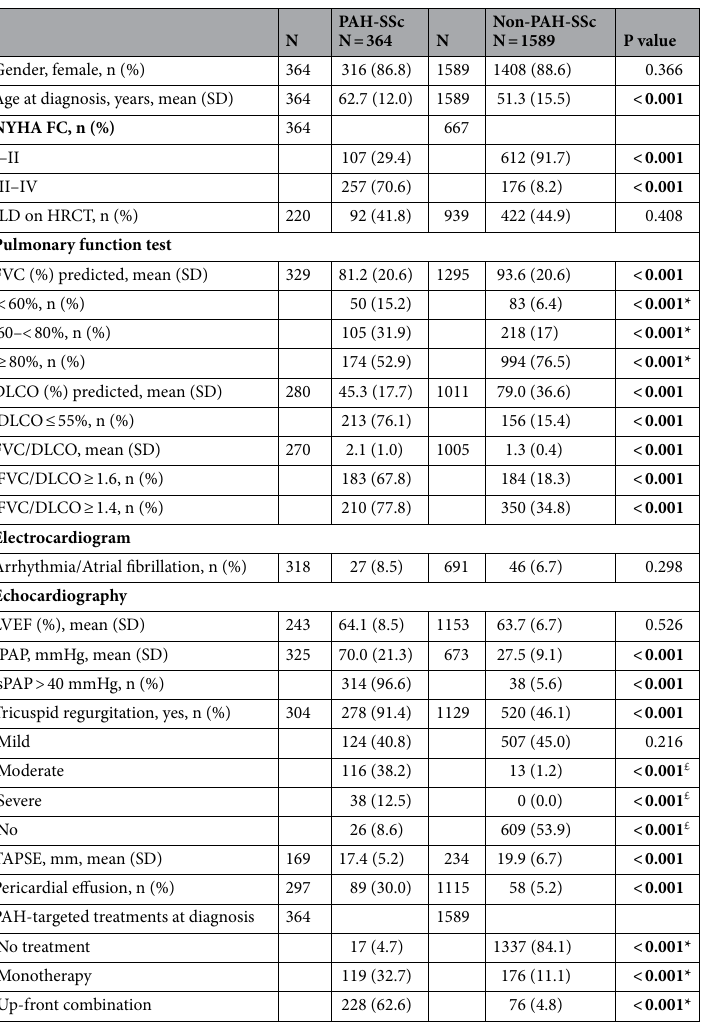
Table 1. Baseline demographic, clinical, and echocardiography data of PAH-SSc (REHAP) and non-PAH-SSc patients (RESCLE). Significant values are in bold. DLCO diffusing capacity for carbon monoxide, FVC forced vital capacity, HRCT high-resolution computed tomography, ILD interstitial lung disease, LVEF left ventricular ejection fraction, NYHA FC New York Heart Association functional class, sPAP systolic pulmonary artery pressure, SD standard deviation, TAPSE tricuspid annular plane systolic excursion. * Statistical significant comparison after Bonferroni correction ( p < 0.017) or £ (p <